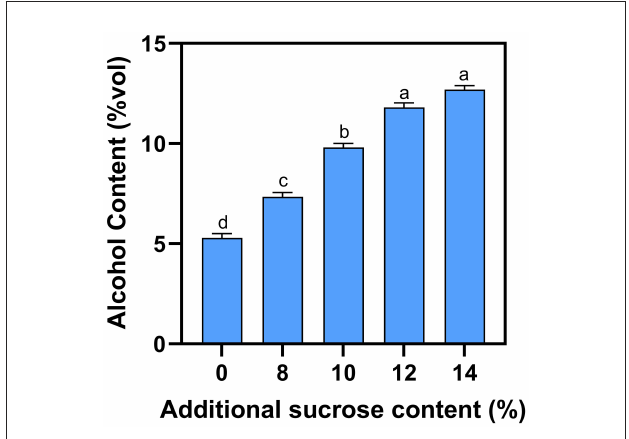
FIGURE1 Effect of additional sucrose on alcohol content. Different superscript letters in the graph are significantly different ( P < 0.05).